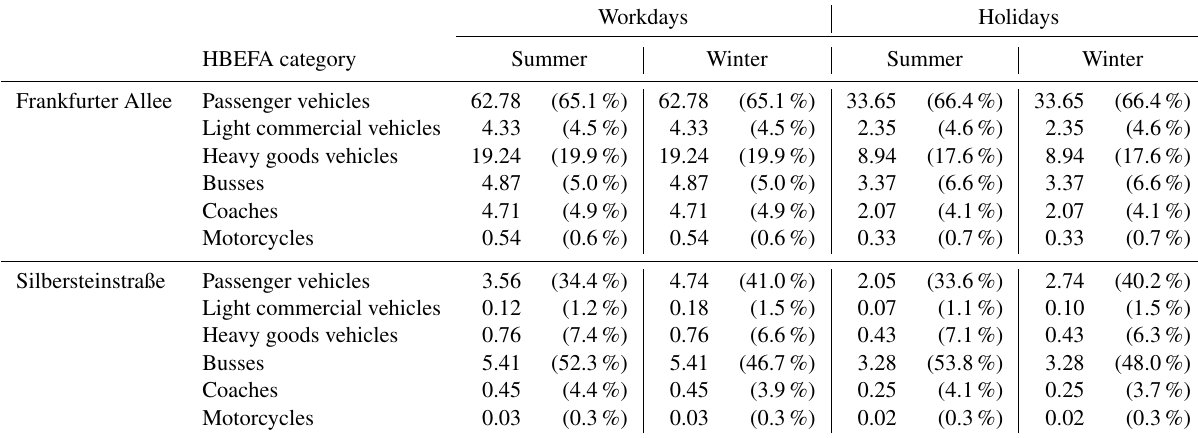
Table 8. Total daily NO x emissions [kg] for typical workdays and holidays from Yeti using mean summer and winter temperature on Frankfurter Allee and Silbersteinstraße in Berlin, classified by HBEFA vehicle categories.